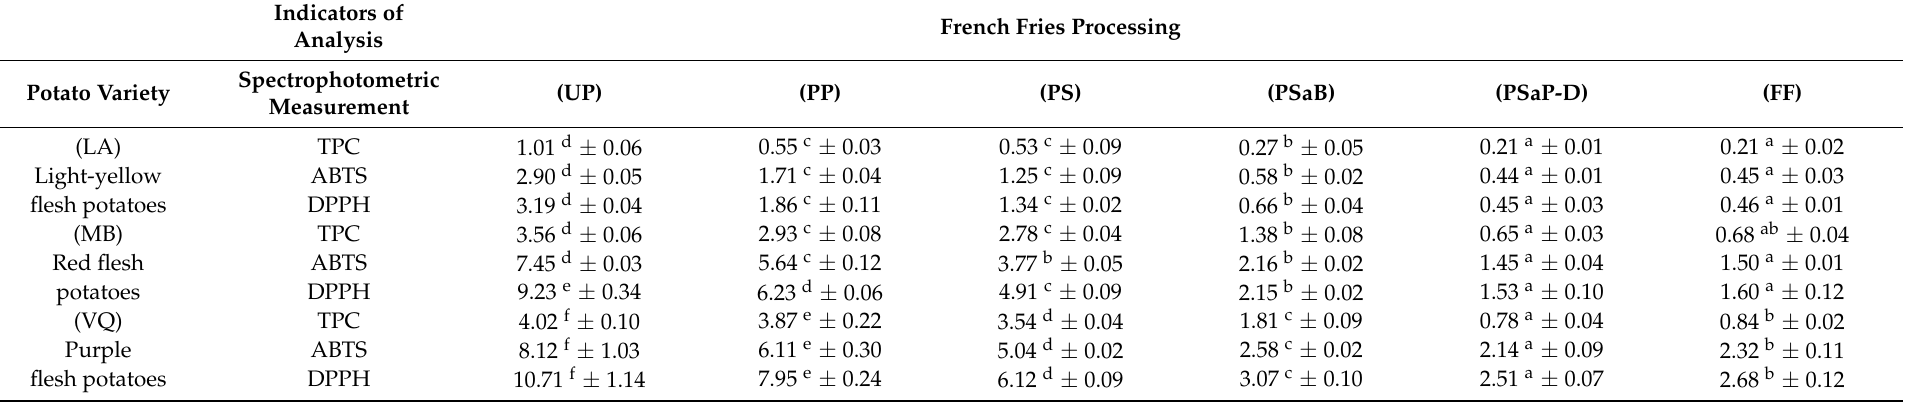
Table 2. Total phenolic content (mg GAE · g − 1 d.w.) and antioxidant activity determined using ABTS and DPPH assay ( µ mol TE · g − 1 d.w.) in potatoes with different coloured flesh and samples obtained during French fries